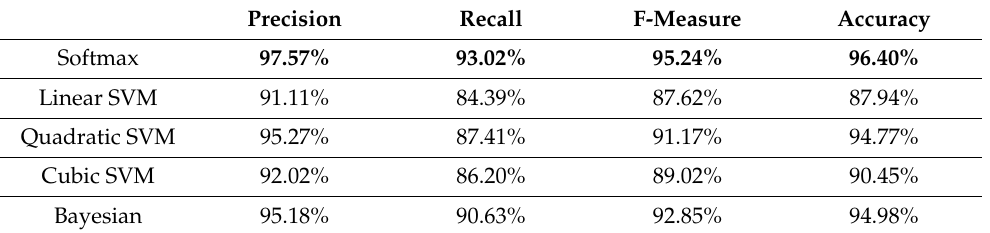
Table 5. Classification performance using contrast-enhanced images after dataset augmentation.